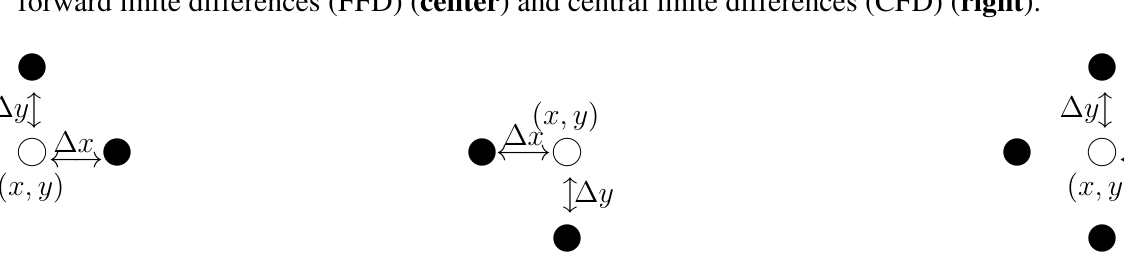
Figure 4. Gradient approximation schemes: backward finite differences (BFD) ( left ); forward finite differences (FFD) ( center ) and central finite differences (CFD) ( right